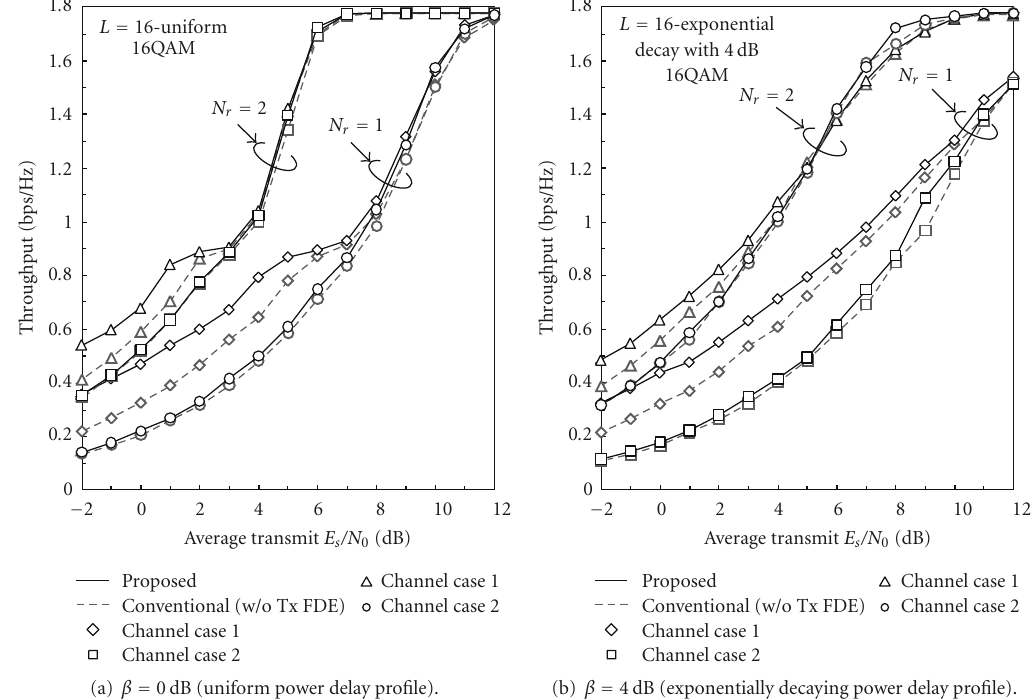
Figure 9: HARQ throughput with